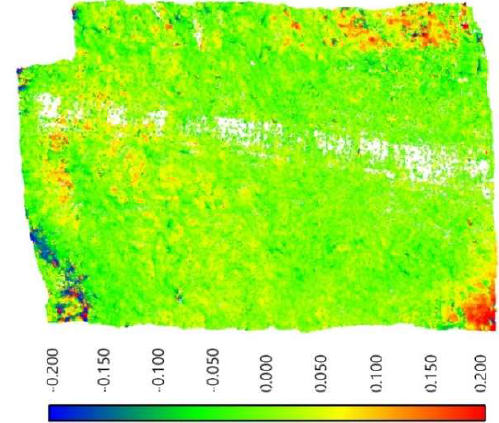
Figure 5. Colour map of distances between the photogrammetric model A1 and the TLS data at the maximum distance of 0.2 m.